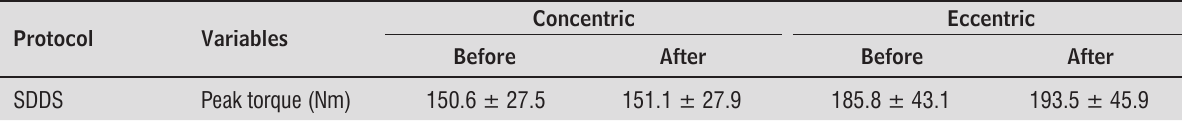
Table 2 - Results corresponding to knee flexors at